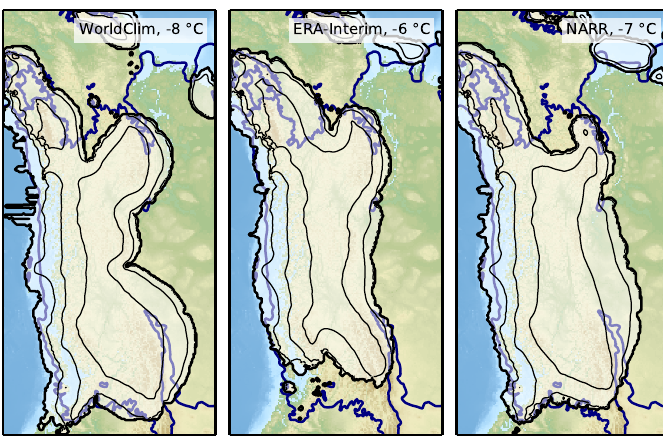
Figure 15. Ice surface topography (1km contours) after 10kyr using temperature offsets resulting in glaciated areas of circa 2 × 10 6 km 2 . A reconstructed LGM ice sheet margin by Dyke (2004) (Fig. 1) is given for reference (blue line).